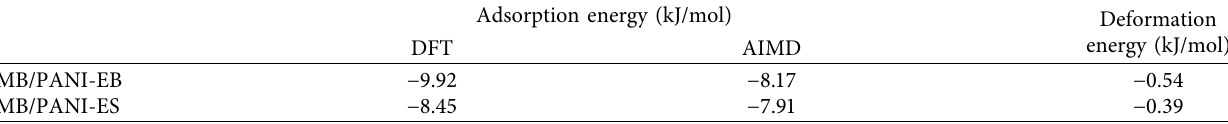
Table 1: DFT and AIMD adsorption energies ( E ads ) of MB on PANI-EB and PANI-ES as well as their deformation